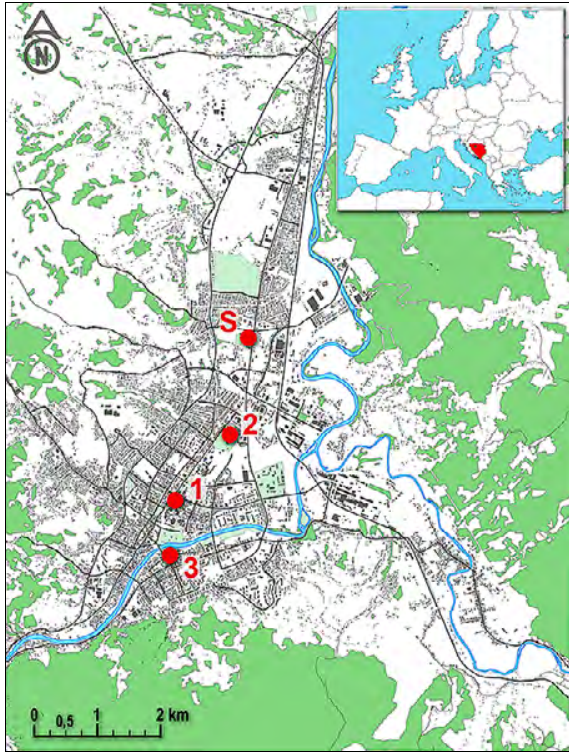
Figure 1. Location of Banja Luka in B&H (black dot) and measurement locations: 1) Downtown; 2) Urban park; 3) Riverside; and S) Official weather station